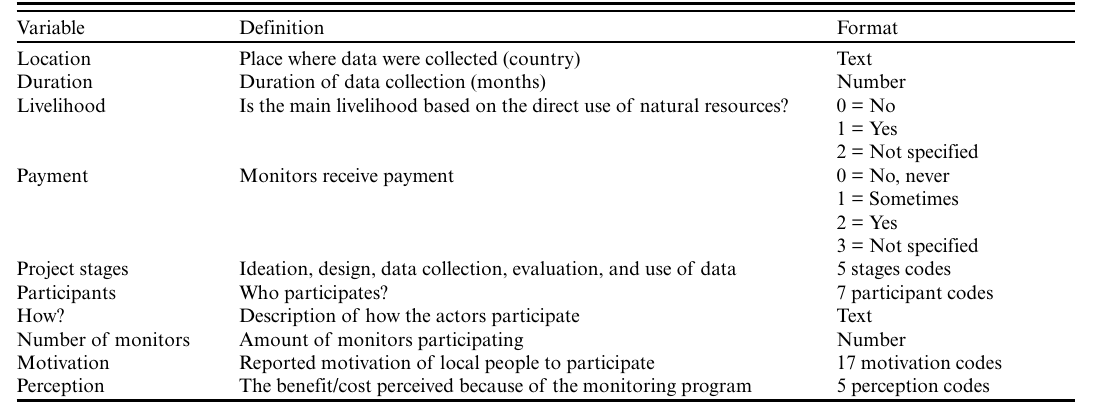
Table 1 . Definition of variables used in the